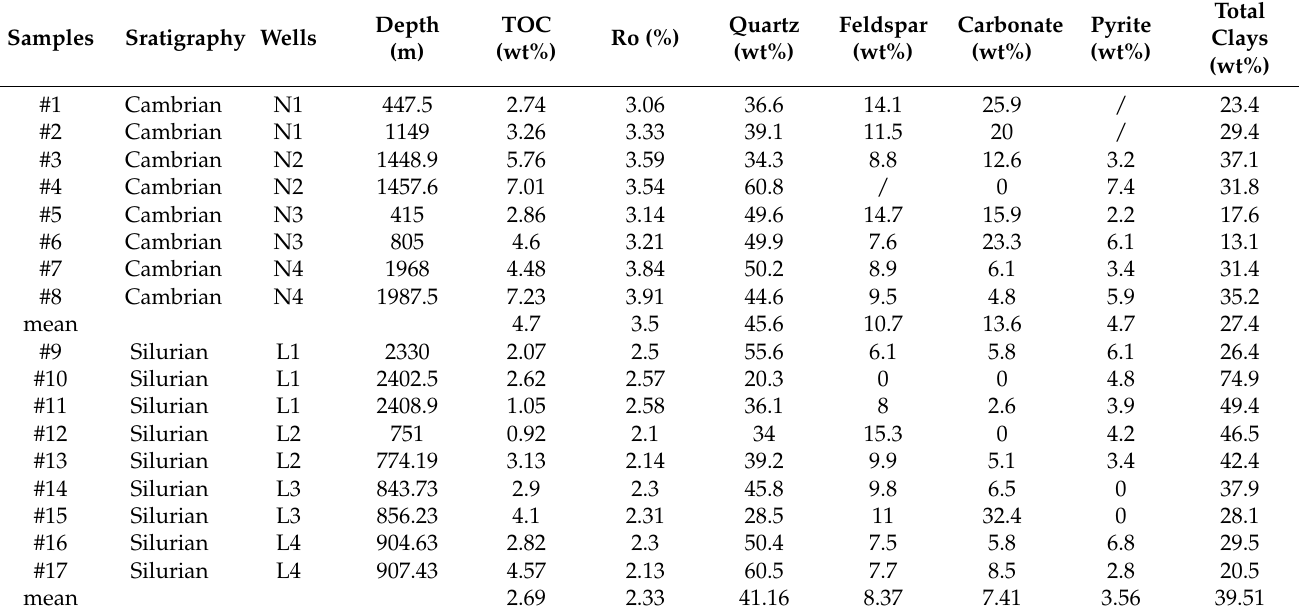
Table 1. Geochemical characteristics, mineralogical compositions, and petrophysical parameters of shale samples from lower Cambrian shale and lower Silurian shale. (Note: % Ro values are from solid bitumen in both studied shales).